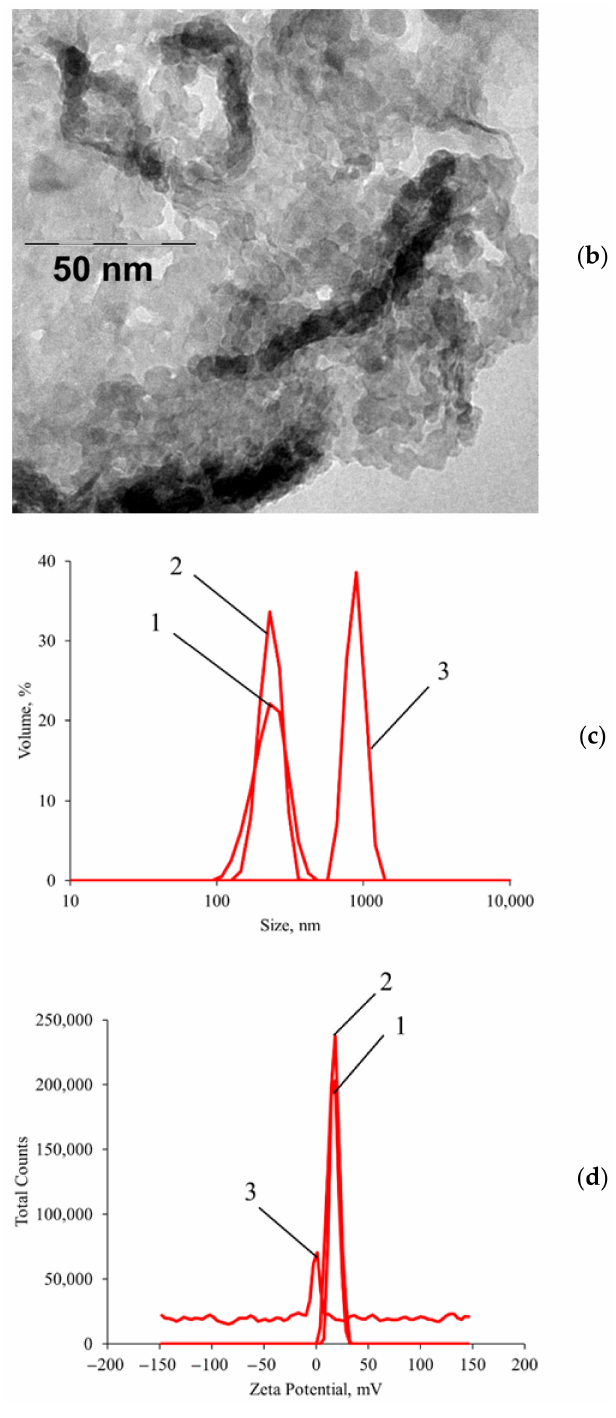
Figure 6. Physical properties of nanomaterials: ( a ) TEM photograph of native trigadolinium penta- iron(III) oxide; ( b ) TEM photograph of trigadolinium pentairon(III) oxide with immobilization of ICG on an amino-spacer; ( c ) Size distribution; ( d ) Zeta potential; (1) Gd 3 Fe 5 O 12 ; (2) Gd 3 Fe 5 O 12 –NH 2 ; (3) Gd 3 Fe 5 O 12 –NH 2